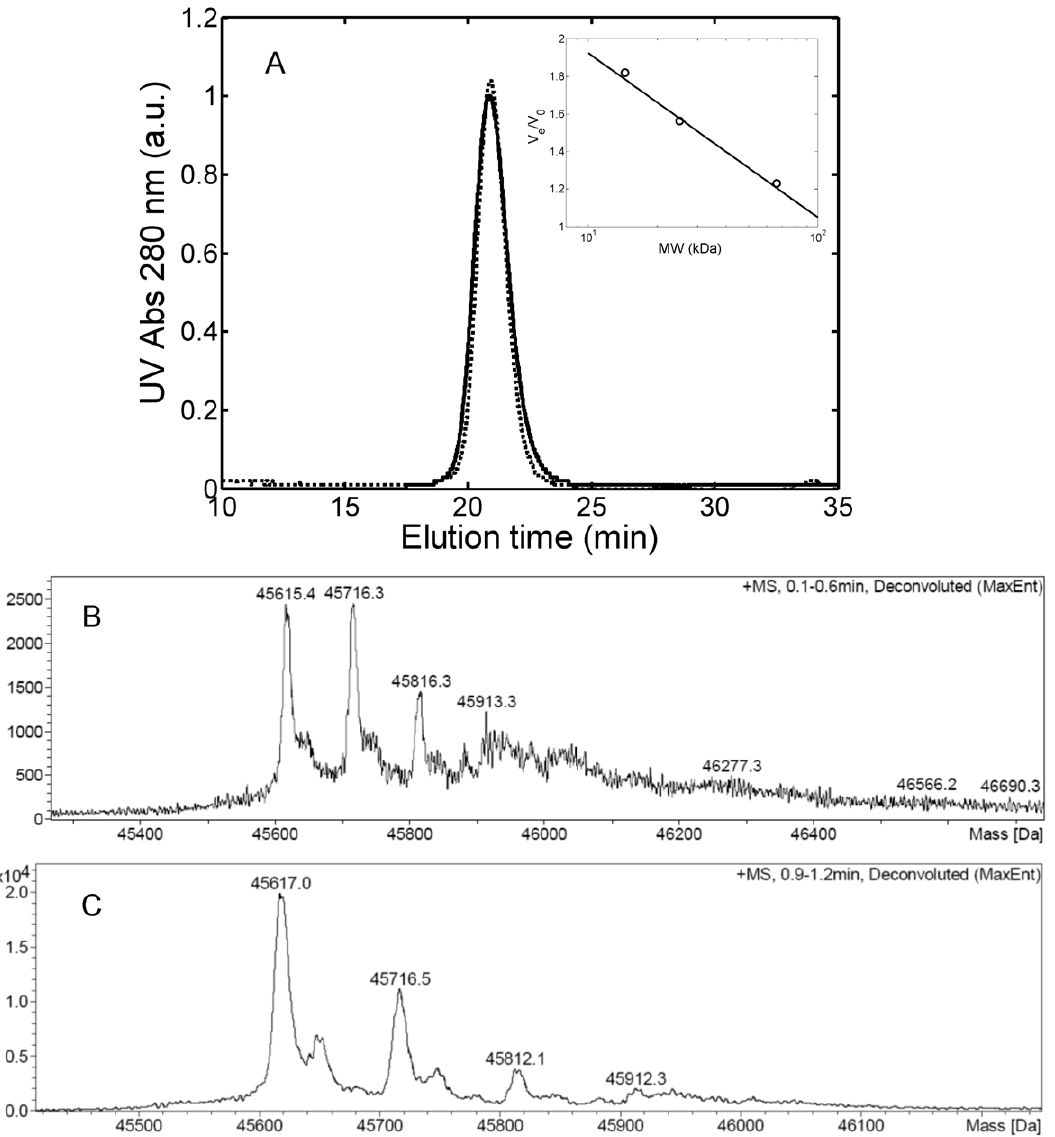
Figure 1. Protein characterization. (A) SEC chromatogram of 1 g/L light chain solution in 25 mM PBS buffer at pH 7.4 (_) and in 20 mM HCl at pH 2.0 (–). Insertion: calibration curve obtained with bovine serum albumin (60 kDa), chymotrypsinogen A (25 kDa) and lysozyme (14.5 kDa); (B) and (C) Mass spectroscopy analysis in 25 mM PBS buffer at pH 7.4 (B) and in 20 mM HCl at pH 2.0 (C).